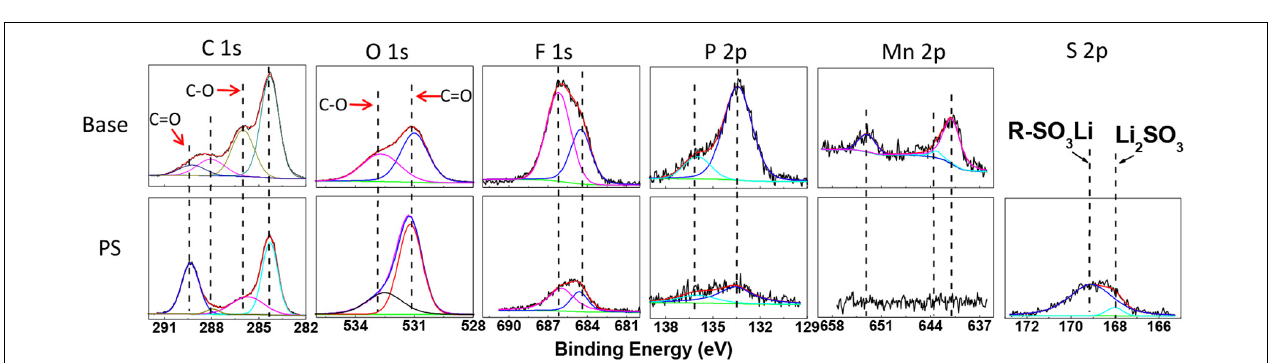
FIGURE 8 | XRD patterns (A) and the magnified XRD patterns in the 17–37 ◦ 2 Theta interval (B) of LiMn 2 O 4 electrodes before and after cycling in the electrolyte with and without 5 wt.% PS.